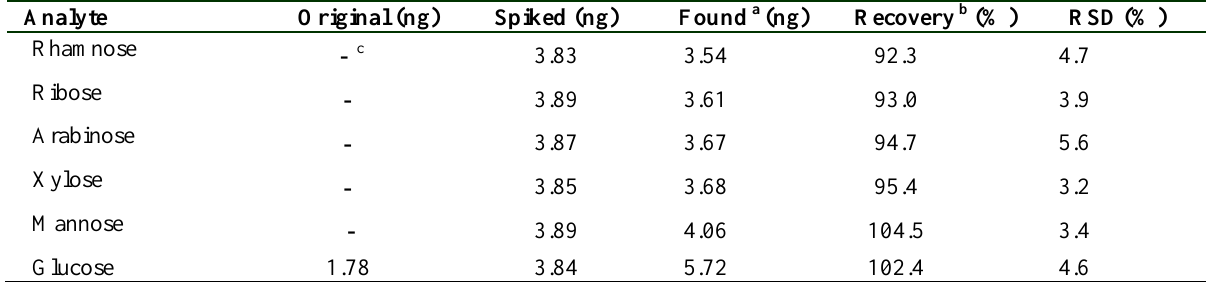
Table 3. Recoveries of 10 monosacharides for the analytical